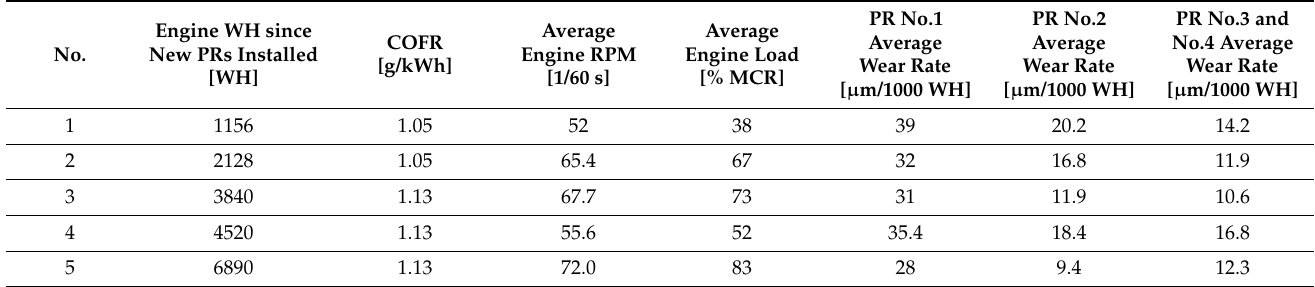
Table 1. Research test results obtained during assessment of Engine No. 1 PRs wear rates.